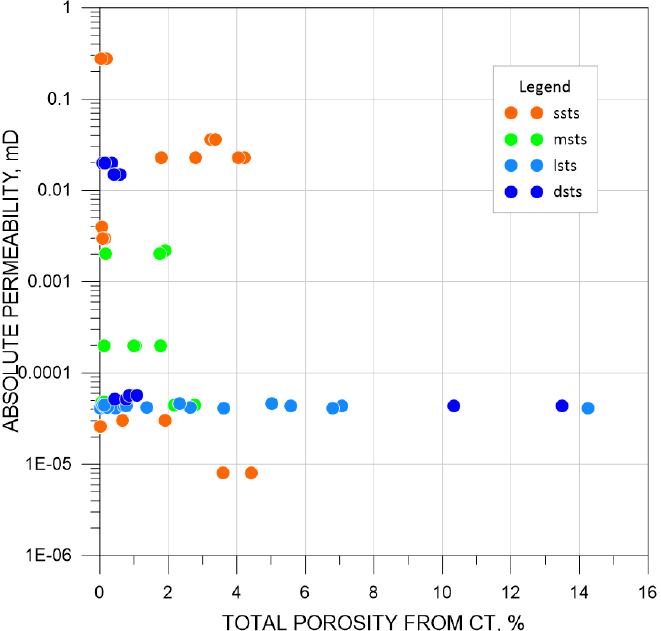
Figure 1. Dependence of absolute permeability from pressure and pulse-decay method on total porosity from CT for all analyzed samples. Symbols: ssts—sandstones, msts—mudstones, lsts— limestones, dsts—dolostones.